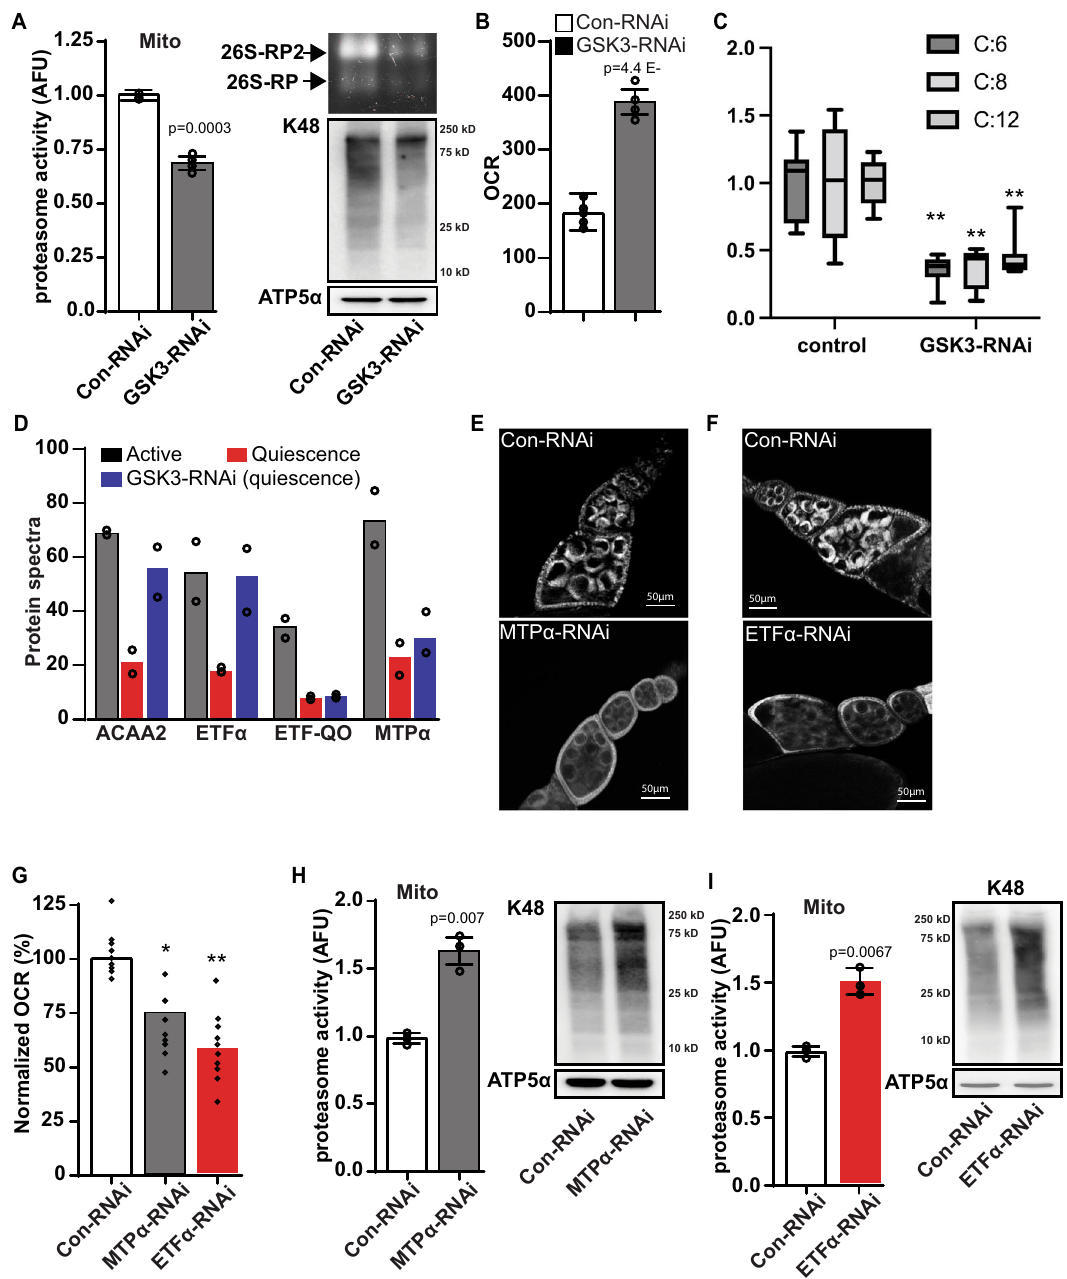
Fig. 2 | GSK3 mediate suppression of fatty acid oxidation triggers proteasome recruitment. A Mitochondria-associated proteasome activity, proteasome zymo- graphy, and K48 ubiquitin levels in mitochondrial fractions in st14 eggs from control-RNAi and GSK3-RNAi ovarioles. (4 replicate experiments on independent biologicalreplicates). B Theoxygenconsumptionrate(OCR)measurementsinst14 eggs from control-RNAi and GSK3-RNAi ovarioles ( n =6 biological replicates). C Acyl-carnitine levels from LC/MS analysis of st14 eggs from control-RNAi and GSK3-RNAi ovarioles( n =8 biological replicates). In the box-and-whisker plots, the box represents the upper and lower quartiles and the line within the box is the mean. The whiskers represent the maximum and minimum values. D Levels of enzymes involved in mitochondrial fatty acid oxidation pathway (FAO) from